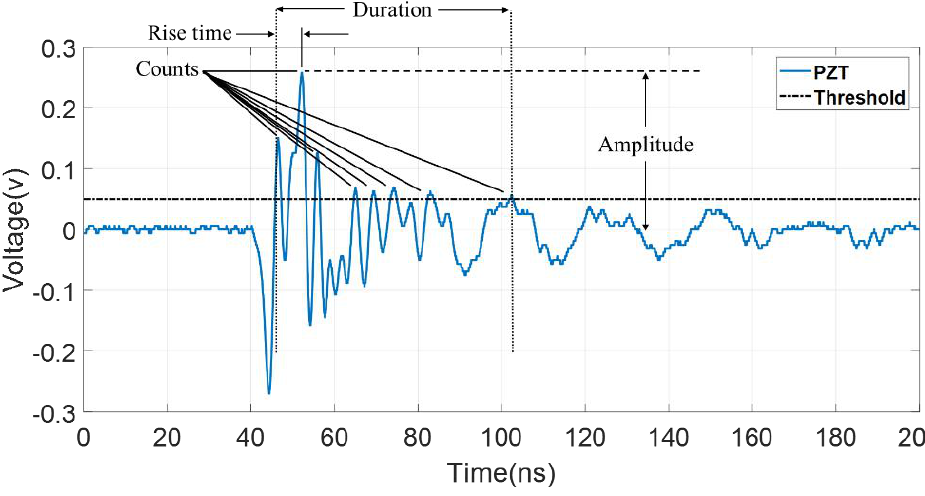
Figure 6. Typical acoustic signals ’ features extracted from PZT Sensor. Table 1. AE signal